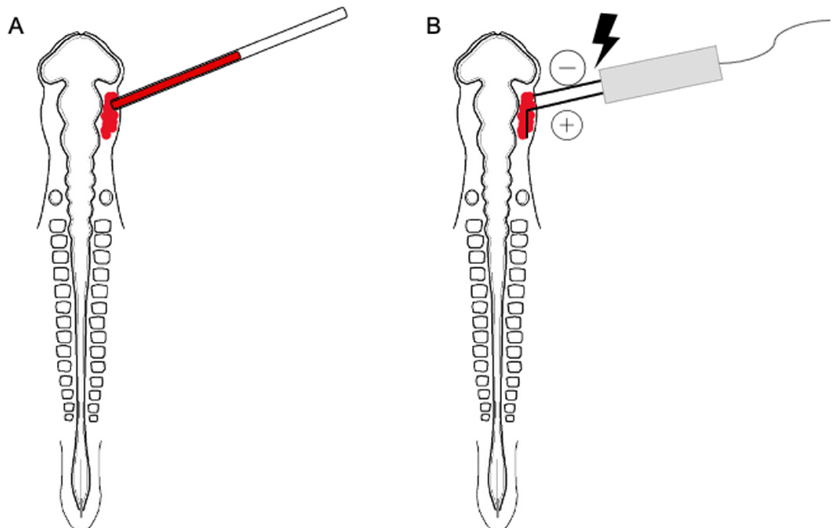
Figure 1. Cartoon diagram showing in ovo MO electroporation. Using a fine glass needle, each MO is overlaid unilaterally on top of the ectoderm of chick embryos ( A ). Next, platinum electrodes are vertically placed across the chick embryo, delivering pulses. Due to the slight positive charge of the lissamine tag, the MO is driven towards the negative electrode and therefore enters the placodal precursor cells in the ectoderm ( B ).